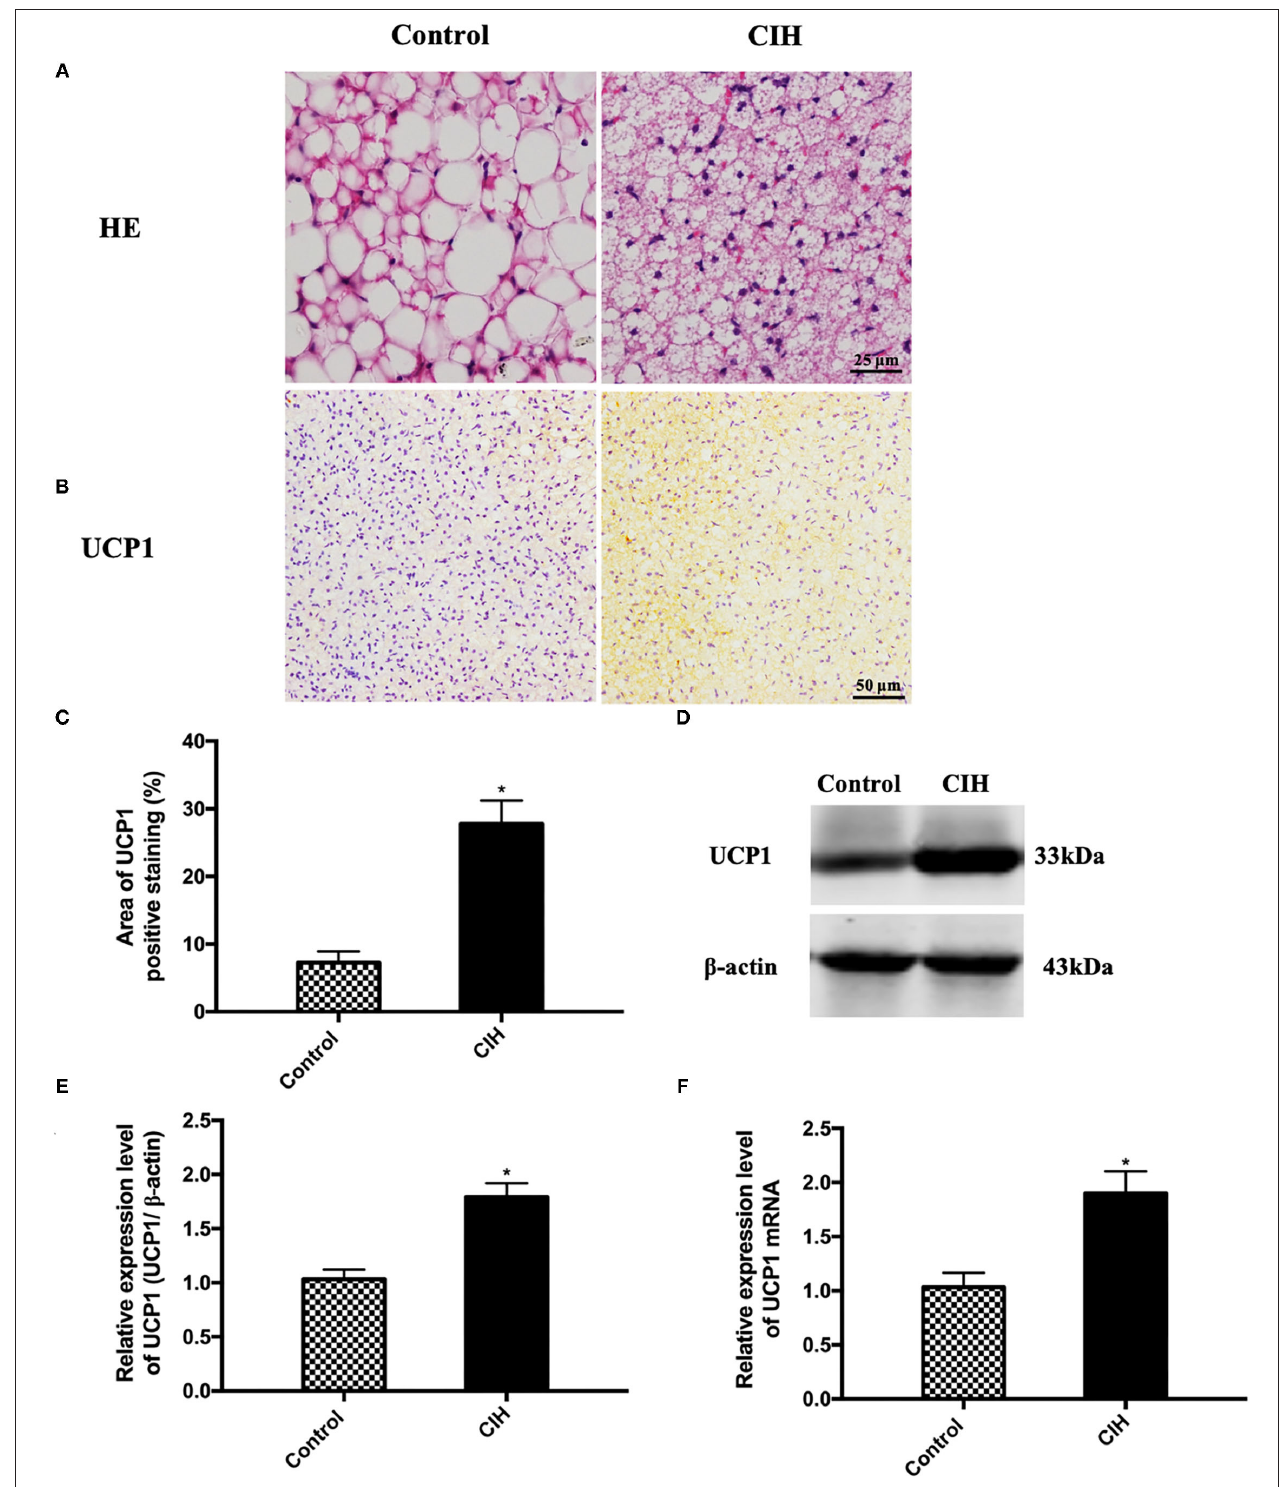
FIGURE 2 | Eight-week exposure of CIH-induced BAT activation in ApoE − / − mice. Male ApoE − / − mice exposed to normoxia or CIH grouped as control and CIH group. (A) Representative photographs of BAT that were stained with HE. (B) Representative photographs of BAT that were immunostained with UCP1. (C) The quantification of UCP1 positive area percentage in BAT. Three serial sections were quantified for each sample. n = 7. (D) Representative photographs of UCP1 western blotting in BAT. (E) Relative expression level of UCP1 in BAT in western blotting. (F) UCP1 mRNA expression in BAT. n = 5. Data were presented as mean ± SEM. * CIH vs. control p <